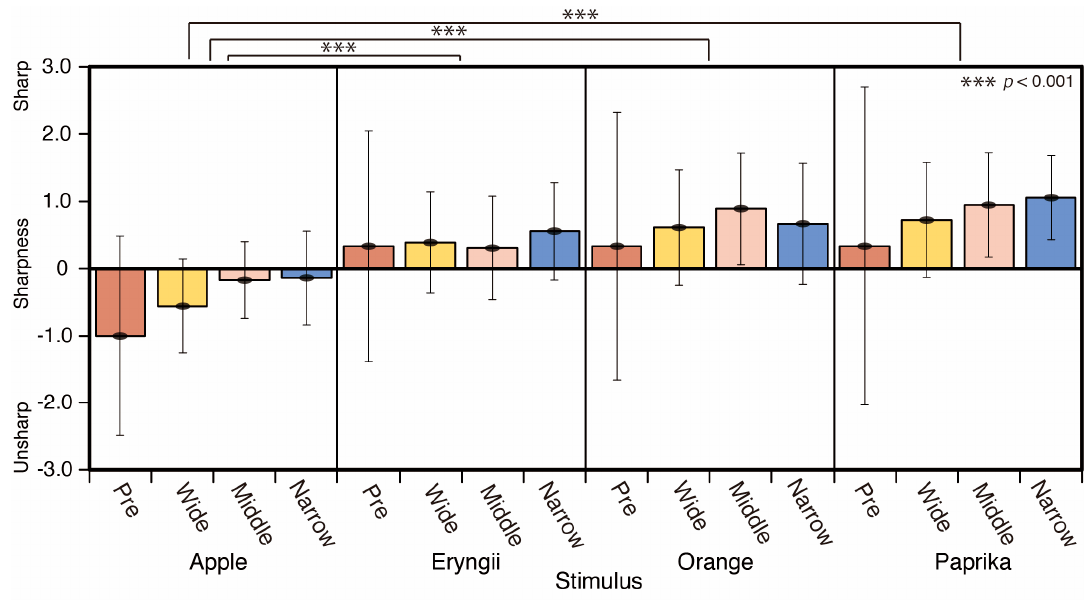
Figure 18. Sharpness scores.